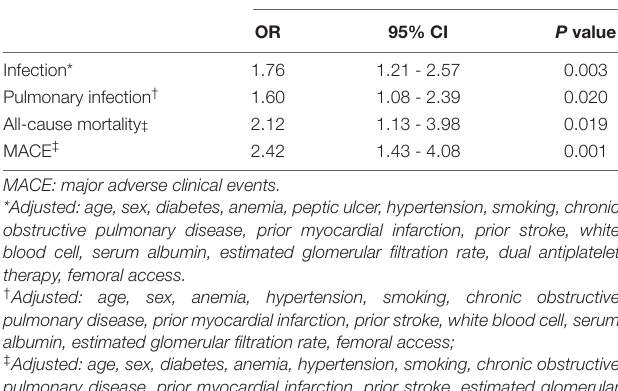
A significant interaction of the effect of PPI on the infection has been found between patients with or without smoking, hypertension, and with eGFR > 60 mL/min/1.73 m 2 or < 60 mL/min/1.73m 2 . Patients with a history of hypertension or with eGFR < 60 mL/min/1.73 m 2 had a higher risk of infections than those without a history of hypertension or with eGFR > 60 mL/min/1.73 m 2 , when they were treated with PPI. However, patients treated with PPI and without smoking had a higher risk of infections than those with smoking ( Figure 3 ).